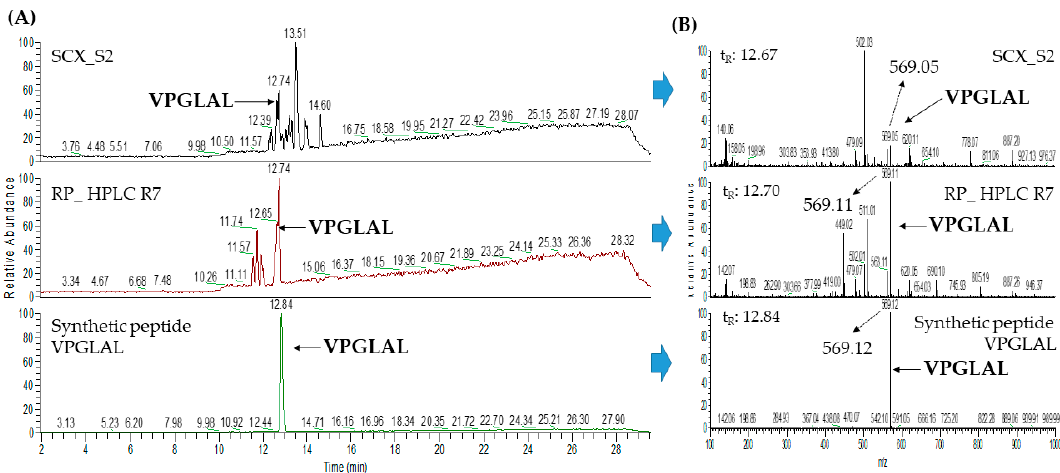
Figure A7. ( A ) LC–MS chromatograms of SCX S2, RP R7, and the synthetic peptide LPSW, ( B ) MS spectra of LPSW originated from fraction SCX S2 ( m / z 502.04, t R 12.63 min), fraction RP R7 ( m / z 502.06, t R 12.61) and synthetic LPSW ( m / z 502.06, t R 12.65).